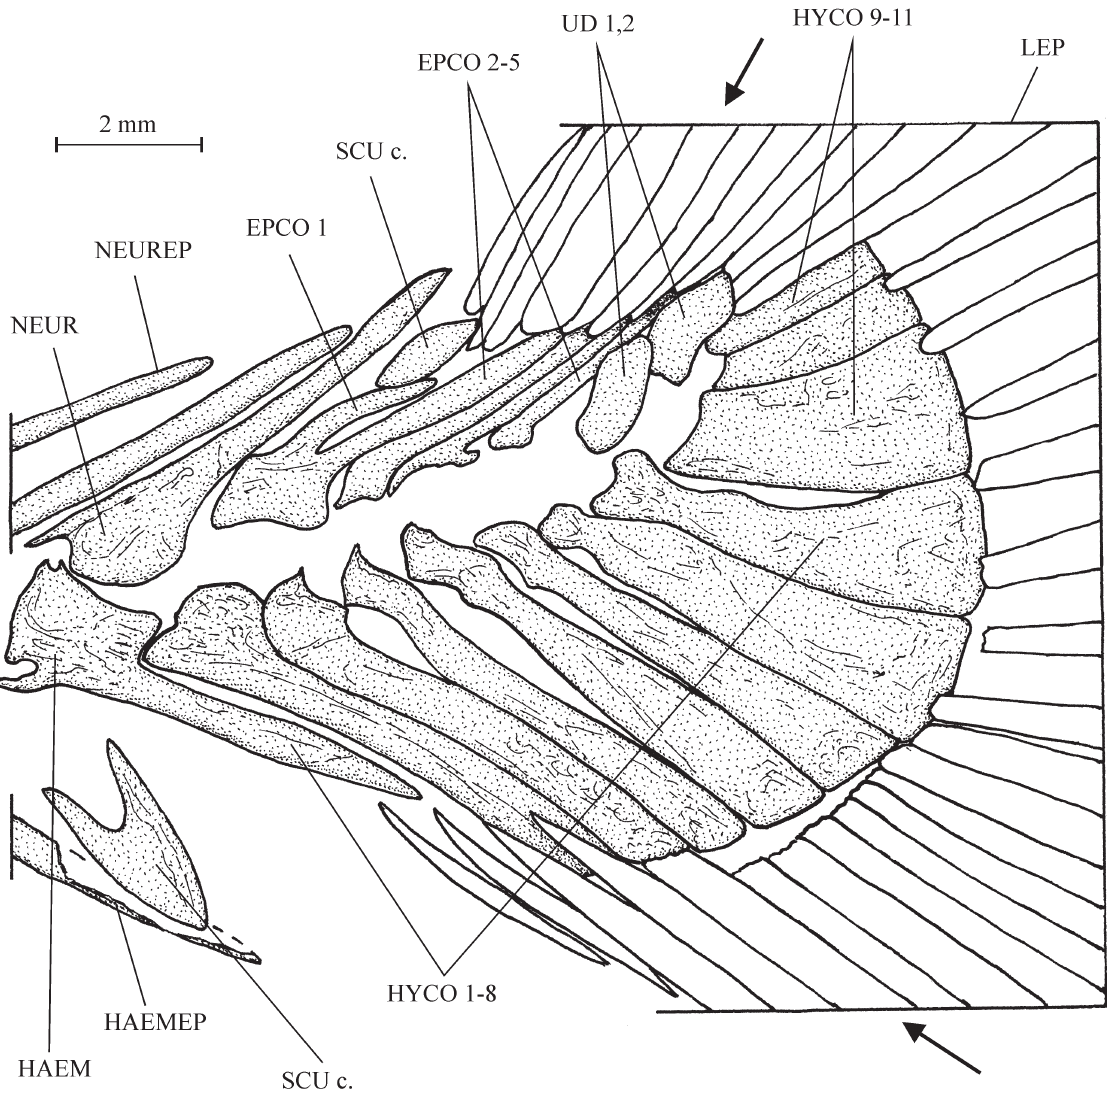
Fig. 17. Acrorhinichthys poyatoi gen. et sp. nov. Caudal skeleton of paratype CLC S-461. The arrows point to the most external principal caudal